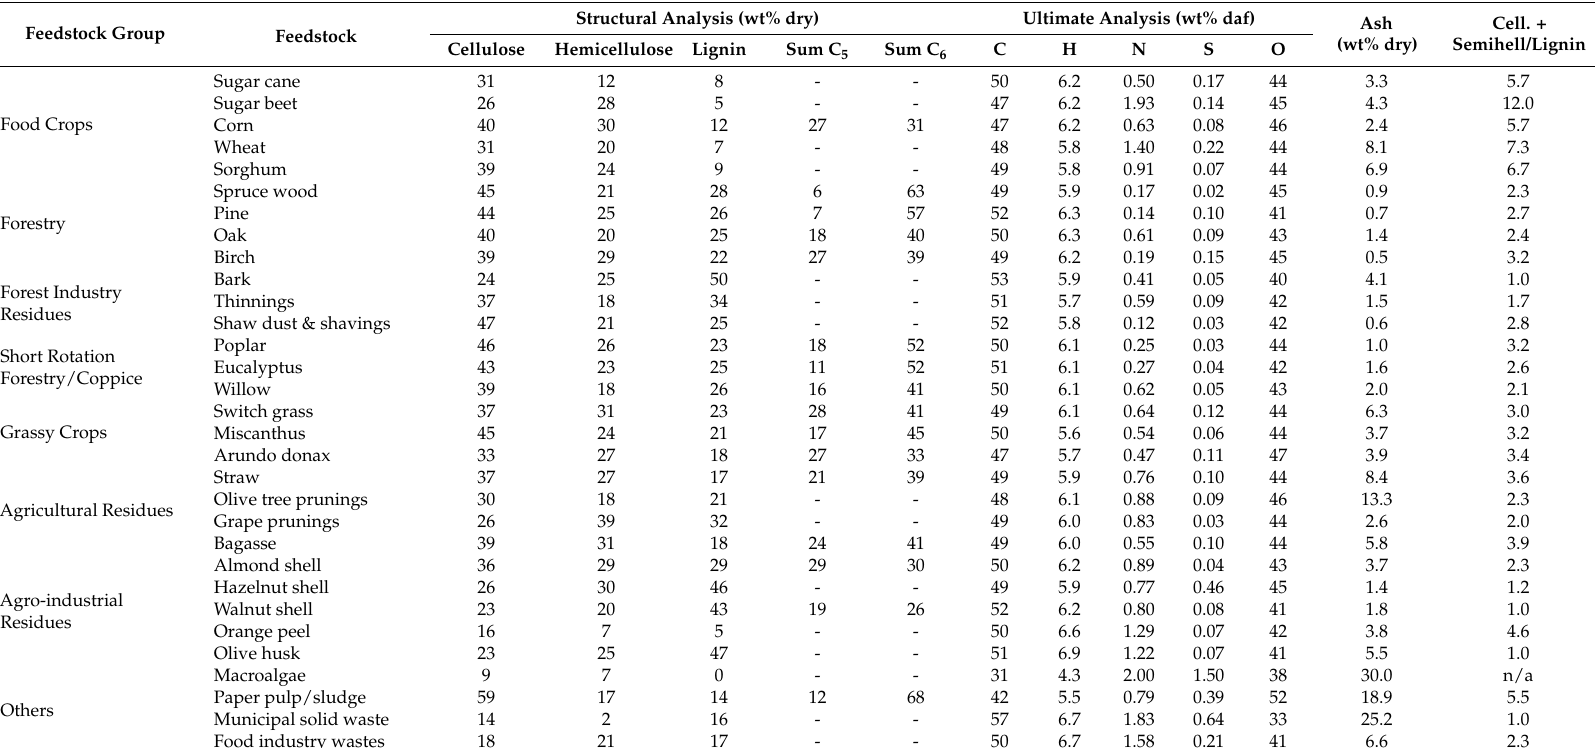
Table 1. Biochemical and chemical analysis of various biomass feedstocks. Data taken from